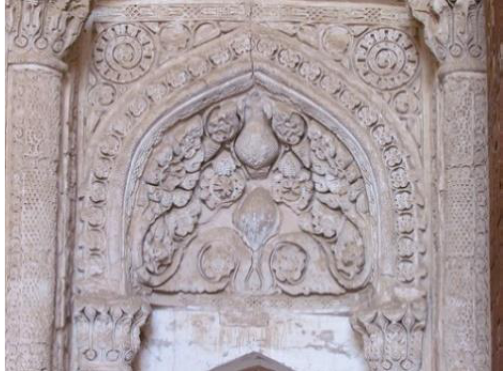
Figure 14. Part of the altar of the Jāmeh Mosque of Nā'īn, Iran Trip